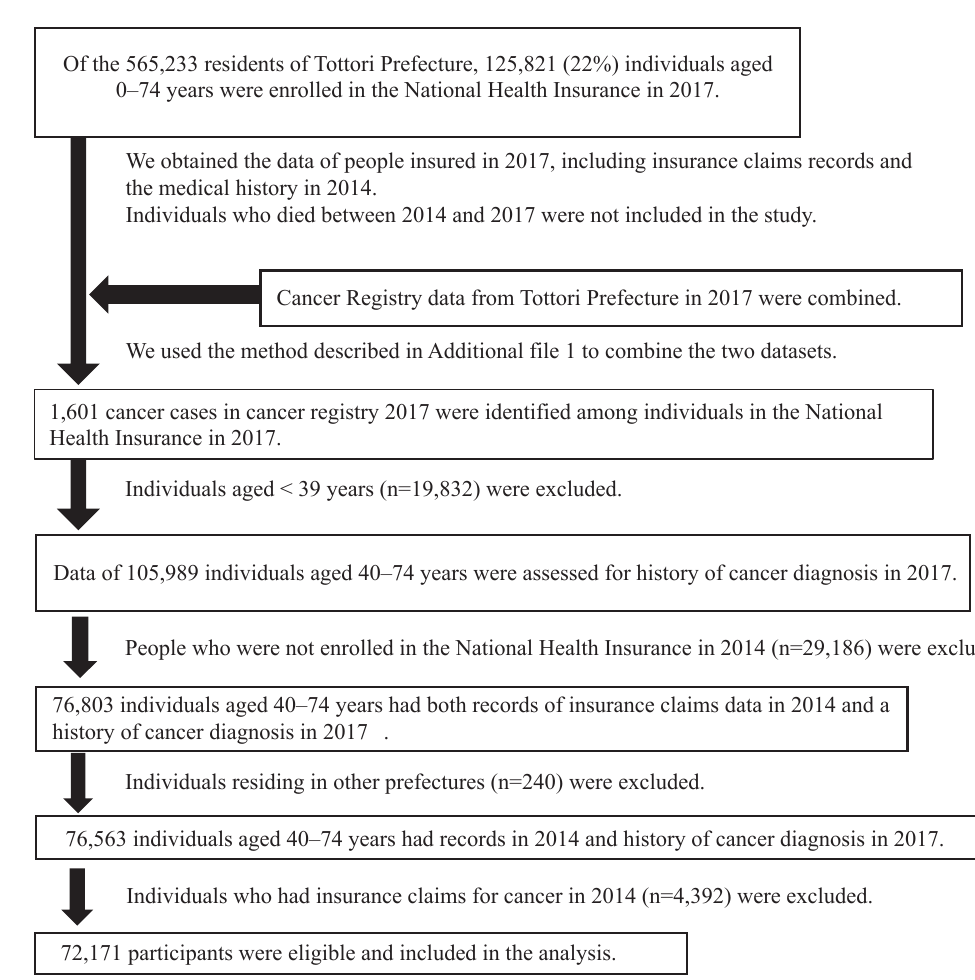
Fig. 1 Patient selection fl ow